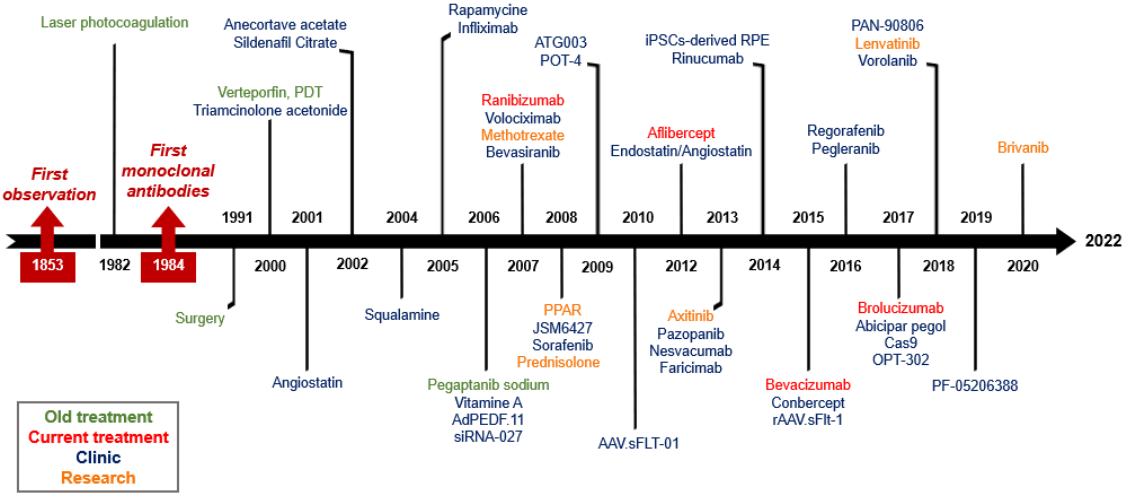
Figure 17. Evolution of exudative AMD treatments.